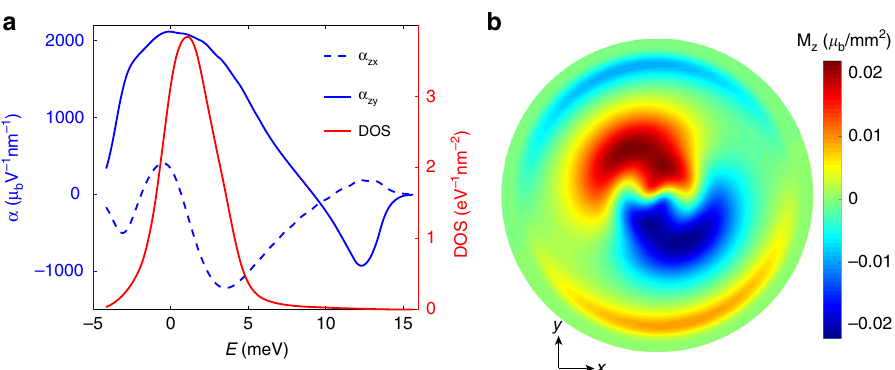
Fig. 3 The magnetoelectric response in strained TBG. a The magnetoelectric susceptibilities α zx , α zy , and the density of states (DOS), both as a function of from bottom to top of the conduction band. We have set ε ¼ 0 : 1 % . b The induced magnetization at the electric fi eld strength 10 4 V/m the Fermi energy E F along different in-plane angles. Increasing radius in the polar plot denotes the Fermi energy increasing from the conduction band bottom to the top. The twist angle is set to be θ ¼ 1 : 2 (cid:5) .